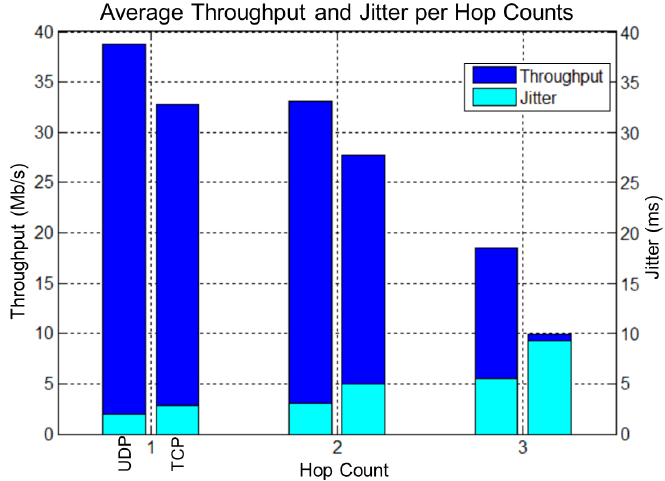
Figure 7. Average TCP and UDP throughput (Mbit/s) and jitter (ms) per hop